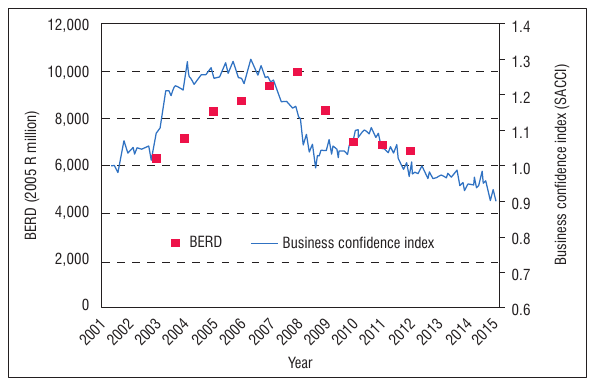
Figure 9: Trends in business confidence and business expenditure on R&D (2001 to